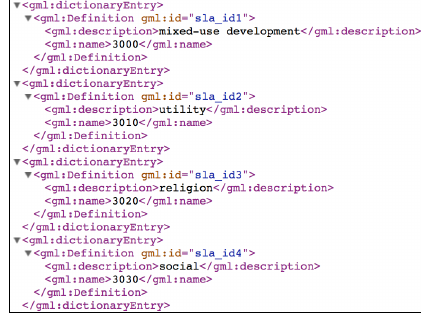
Figure 4. Cross-referencing has been created between LOD 1 and LOD 2